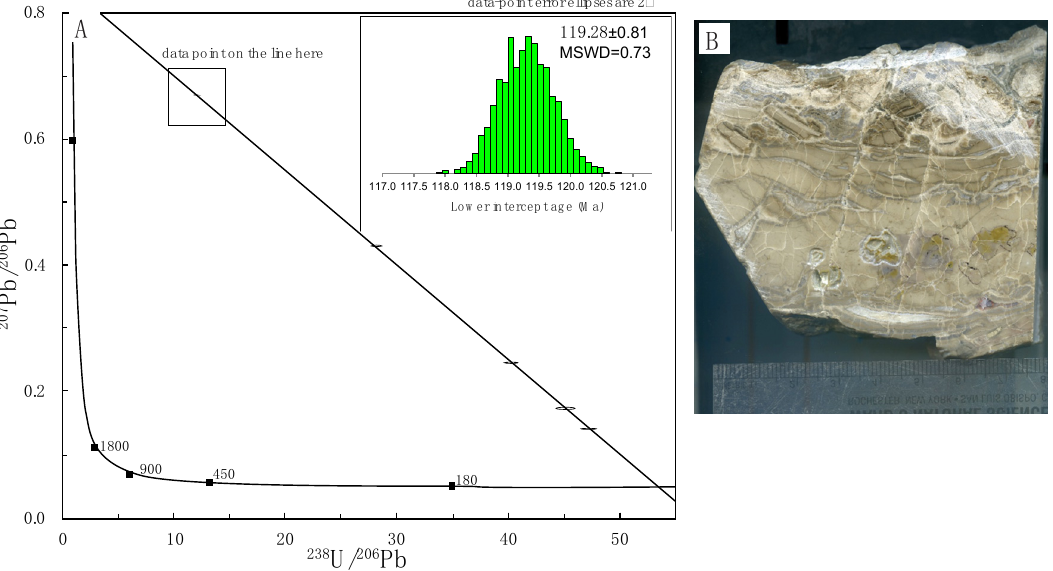
Figure 8. ( A ) Tera–Wasserburg concordia plot of ID-TIMS data. The insert is a histogram of ages based on 1000 Monte Carlo simulations based on the five data points. ( B ) Slab of the Cedar Moun- tain Formation carbonate that was dated. The micrite in the lower middle part of the sample where there are holes was microdrilled. Two of the sampled areas are on the back of this slab, but along the same horizon. The yellow areas have the highest U concentrations based on phosphor imaging